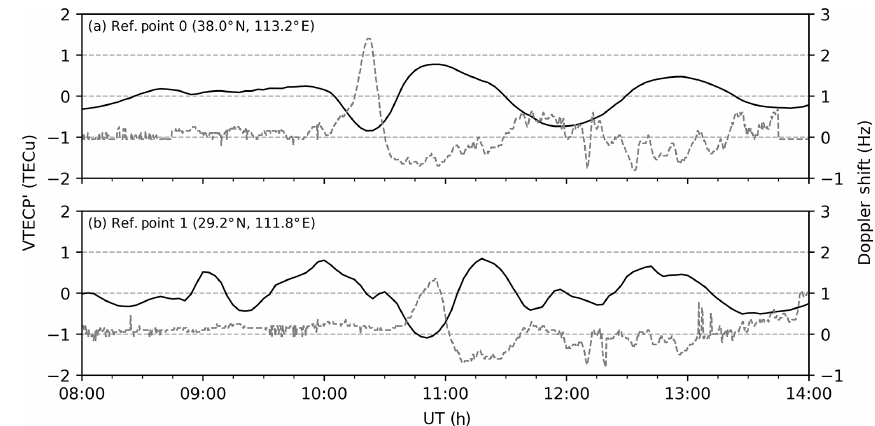
Figure 5. Temporal variations in mean VTECP (cid:48) near the Doppler reflection points between 08:00 and 14:00UT, 17 March 2015. Doppler shift recordings in Fig. 3 are plotted with dashed lines for